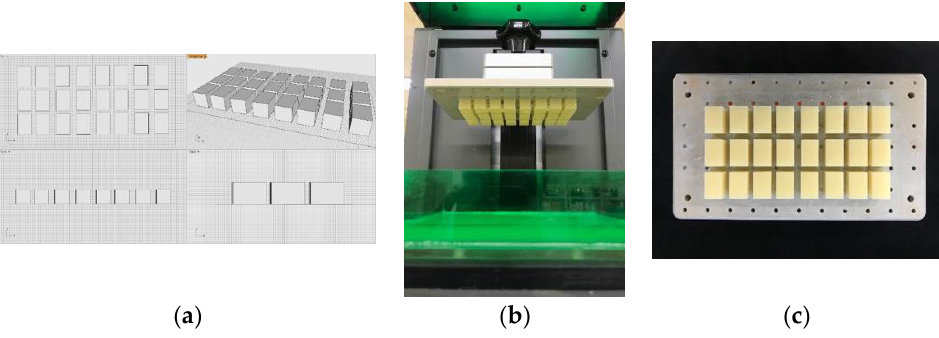
Figure 1. 3D printed resin specimens were fabricated from a DLP 3D printer. ( a ) preprocessing before 3D printing; ( b ) printed specimens on build platform in the 3D printer; and ( c ) 3D printed specimens after primary wash.